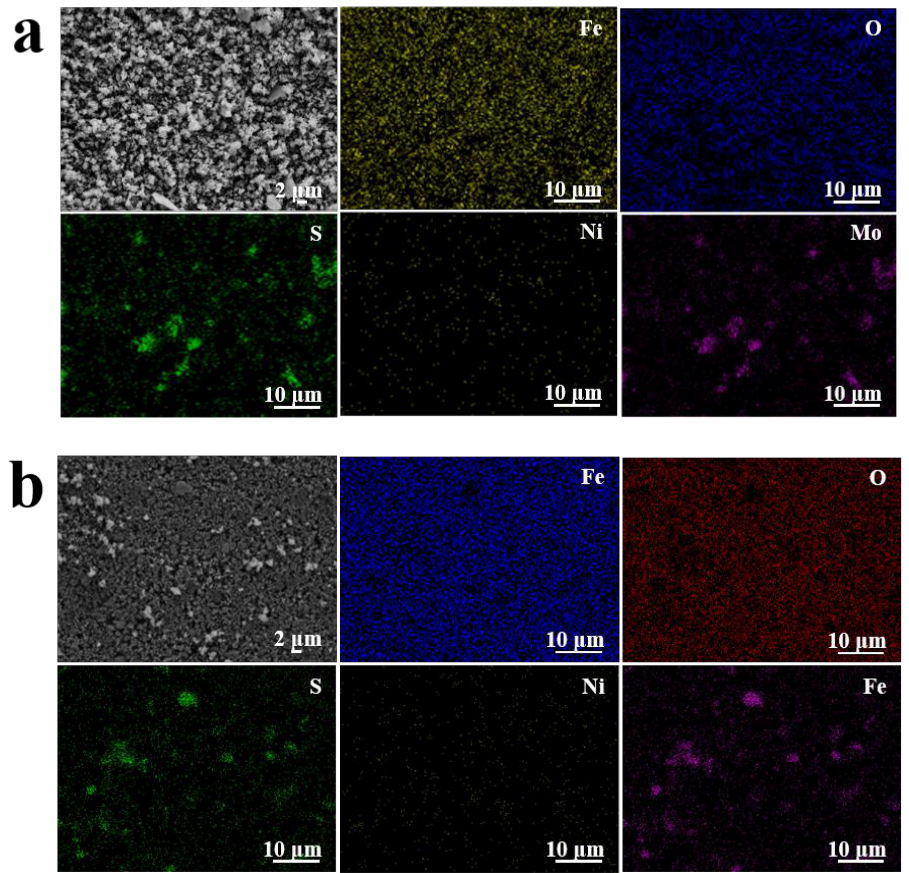
Figure 3. EDX images of the Fe 3 O 4 /MoS 2 /NiS (5%) powder ( a ) and the electrode sheet ( b ).